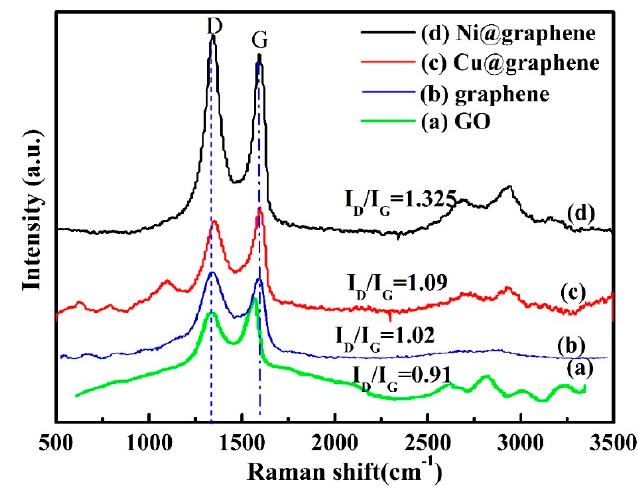
Figure 6. Raman spectra of ( a ) GO; ( b ) graphene; ( c ) Cu@graphene and ( d ) Ni@graphene.